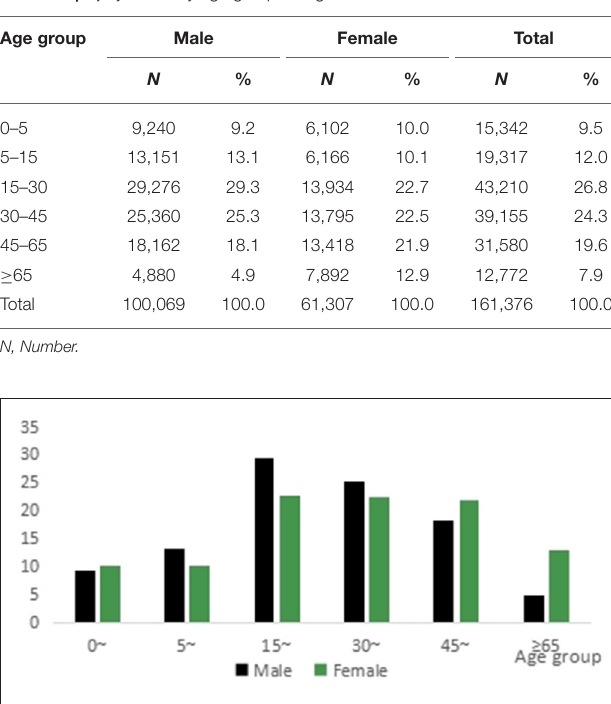
TABLE 2 | The proportions of injuries sustained at different places by gender.